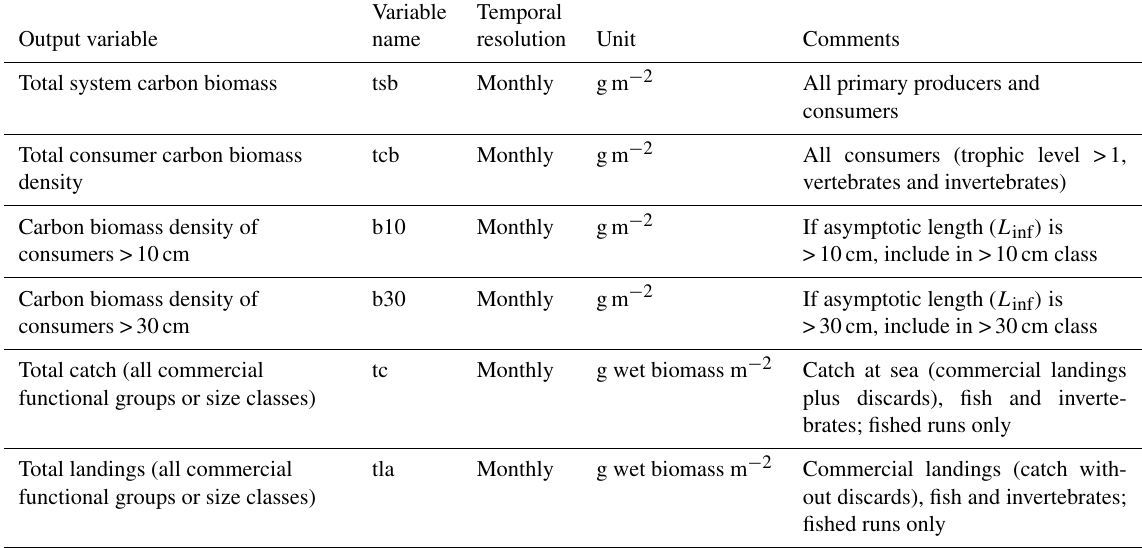
Table 5. Common output variables to be provided by global and regional marine fisheries